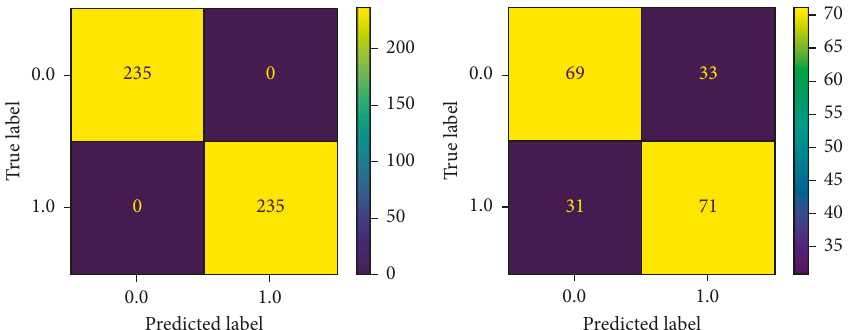
Figure 4: Confusion matrix for proposed method for BULP dataset. Left figure is for training, and right figure is for testing